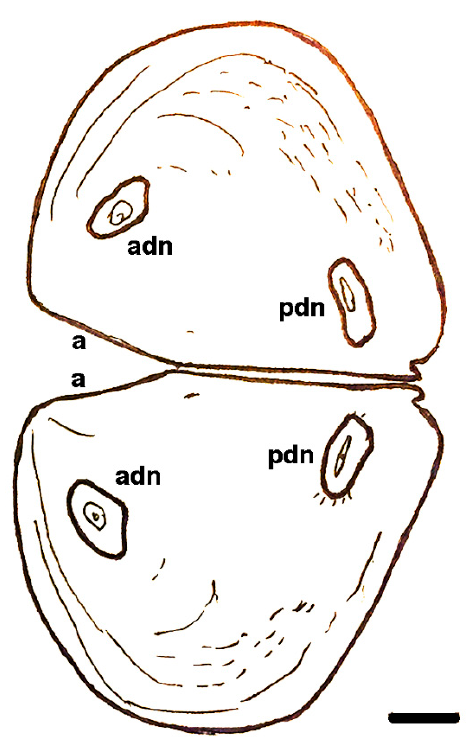
Figure 28. Quadricona madonnae . Paired shields shown in butterfly position. Anterior to left. Scale bar 200 microns. Abbreviations: a, anterodorsal cardinal marginal concavity; adn , anterodorsal node; pdn , posterodorsal node. Image Credit: Mark McMenamin.